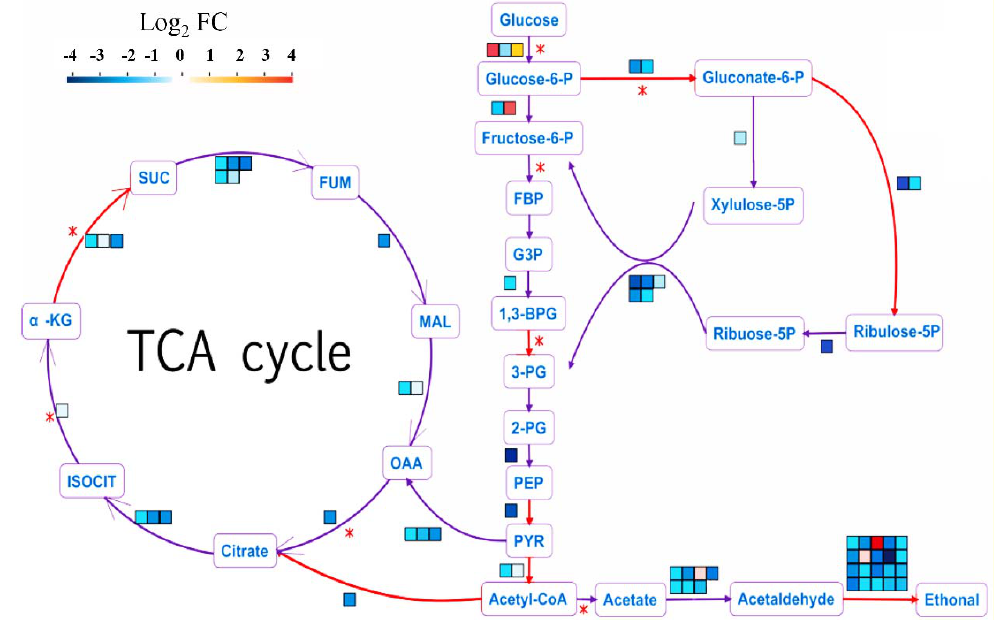
Figure 6. Glycolysis pathway and TCA cycle in response to HSAF. The red asterisk indicates key pacemaker enzyme for the pathways. The red arrow represents the exergonic reaction. One square denotes one gene in related reaction and its color implies the gene’s expression level. The asterisks (*) indicate the key reaction. FC (Fold change of RPKM (HSAF)/RPKM (CK)), PGI1 (glucose-6-phosphate isomerase), FBA1 (fructose-bisphosphate aldolase), FBP1 (fructose-1,6-bisphosphatase), TDH1 (glyceraldehyde-3-phosphate dehydrogenase), PGK1 (phosphoglycerate kinase), ENO1 (enolase), PYK1(pyruvate kinase), PDA1 (pyruvate